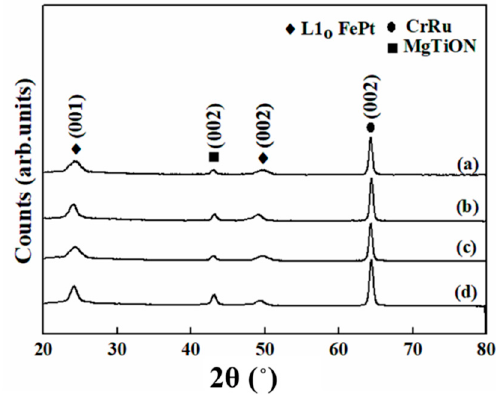
Figure 1. XRD of FePt(BN, Ag, C)( x vol.%)/MoC( y nm)/MgTiON/CrRu/glass films, ( x , y ) = ( a ) (0, 0), ( b ) (10, 0), ( c ) (0, 3), ( d ) (10, 3).